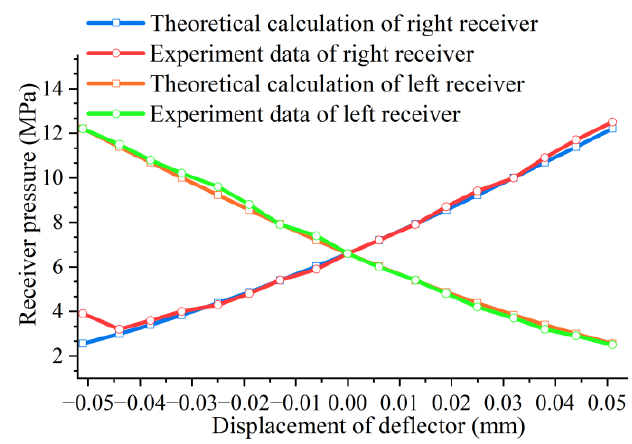
Figure 18. Comparison of receiver pressures.